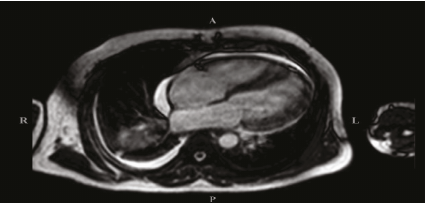
Figure 4: Contrast-enhanced cardiac MRI: contrast late enhancement study shows di ff use patchy contrast late enhancement mostly involving mid- and epicardial layer of myocardium, more at the midlateral wall and inferior wall which can be consistent with myocarditis. Small pericardial e ff